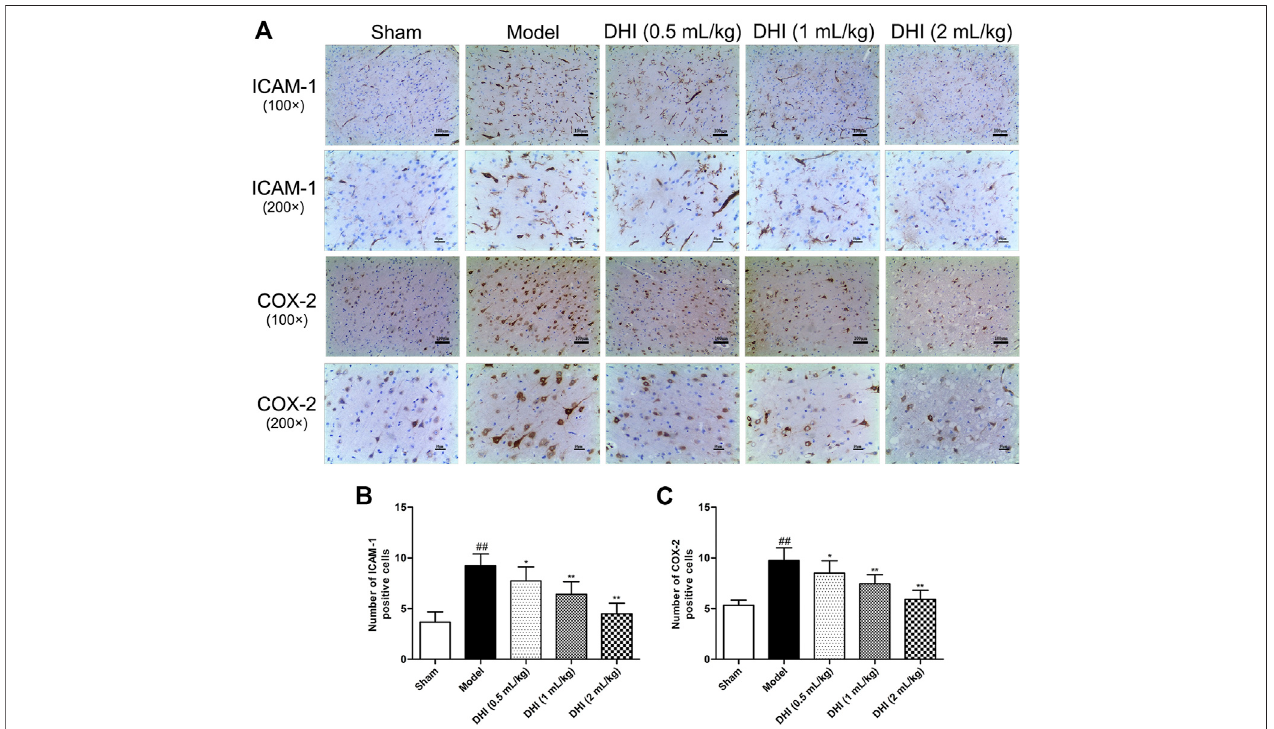
FIGURE 6 | Effects of DHI on the protein expressions of ICAM-1 and COX-2 at 24 h after CIRI in rats. (A) Representative immunohistochemical images of ICAM-1 and COX-2, Iba-1, and GFAP in the penumbra of ischemic ipsilateral parietal cortex after CIRI in rats at 100 × and 200 × magni fi cation. (B, C) Immunohistochemical analysis of ICAM-1 and COX-2 in the penumbra of ischemic ipsilateral parietal cortex after CIRI in rats. Mean ± SD ( n (cid:2) 6). Asterisks denote the signi fi cant levels: ## P < 0.01 vs. sham group and * P < 0.05 and ** P < 0.01 vs. model group.